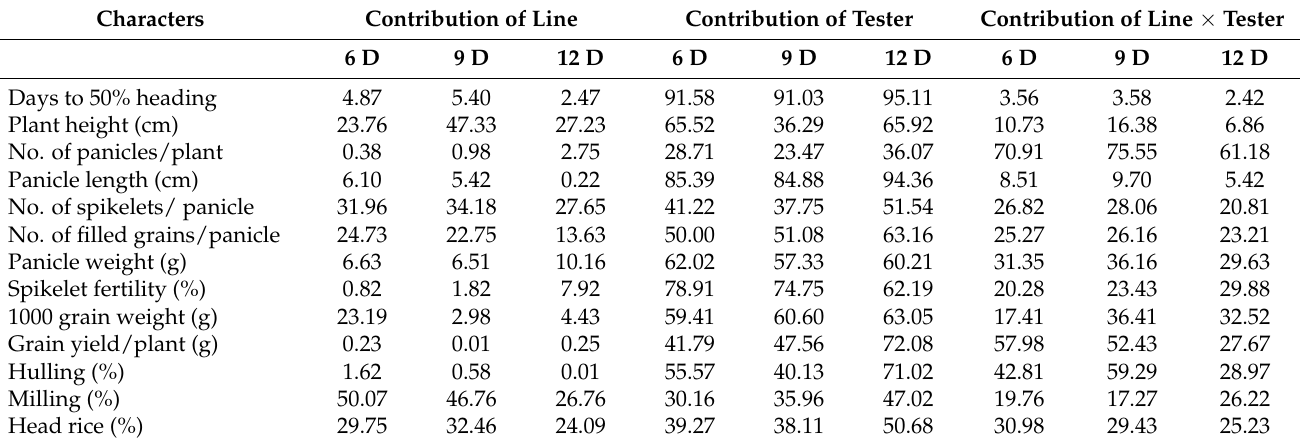
Table 11. Percent contribution of different components (lines, testers, and lines × testers) towards the crosses’ sum of squares for various traits in rice under three irrigation regimes (6, 9, and 12